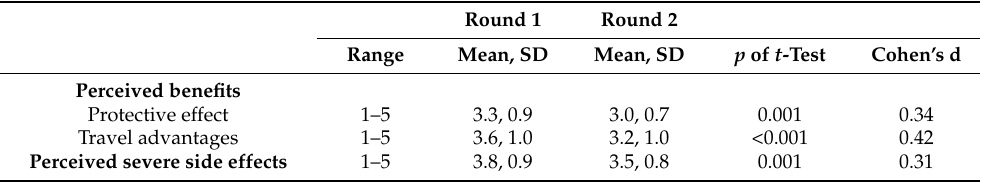
Table 4. Comparisons of perceptions related to COVID-19 vaccination assessed in the two surveys.